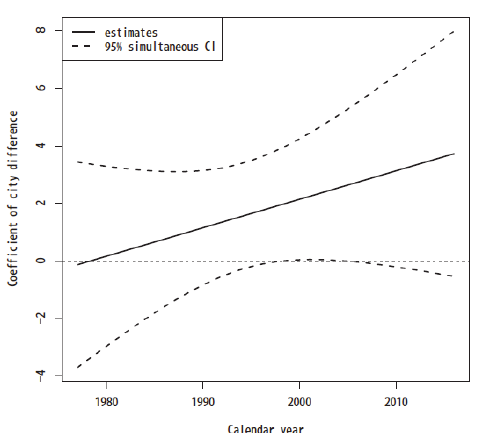
Fig. 15. Observed and predicted probability of appearance for "law"